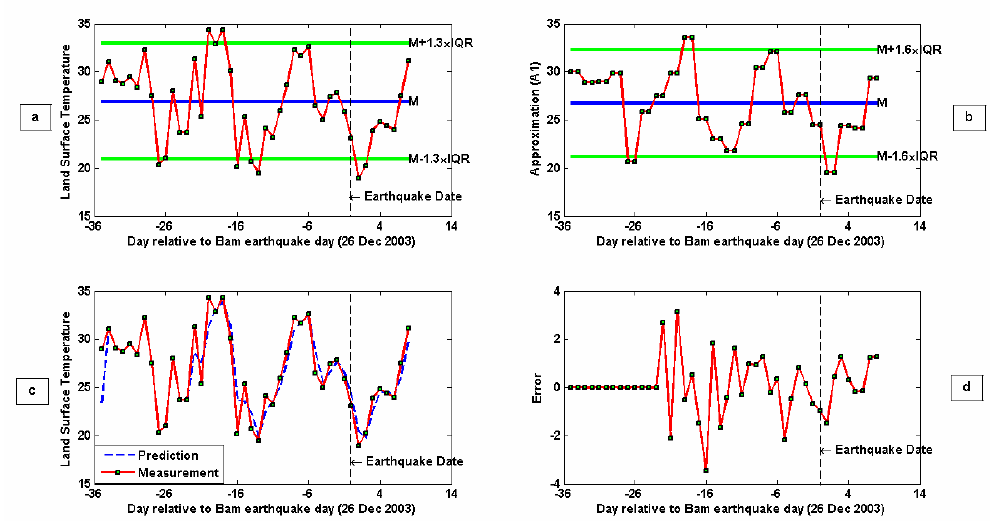
Fig. 4. Results of LST data analysis for the Bam earthquake (26 December 2003) from 20 November 2003 to 03 January 2004. The earthquake day is represented as a vertical dotted line. The green horizontal lines indicate the higher and lower bounds. The blue horizontal line indicates the median value. The x -axis represents the day relative to the earthquake day. The panel represents (a) LST variations and detected anomalies using interquartile methods, (b) LST variations after implementing the wavelet transformation and detected anomalies using interquartile methods, (c) Observed LST variations (red) and predicted LST variations (blue) using the Kalman filter method and (d) the differences between the observed LST and the predicted LST values using the Kalman filter method.